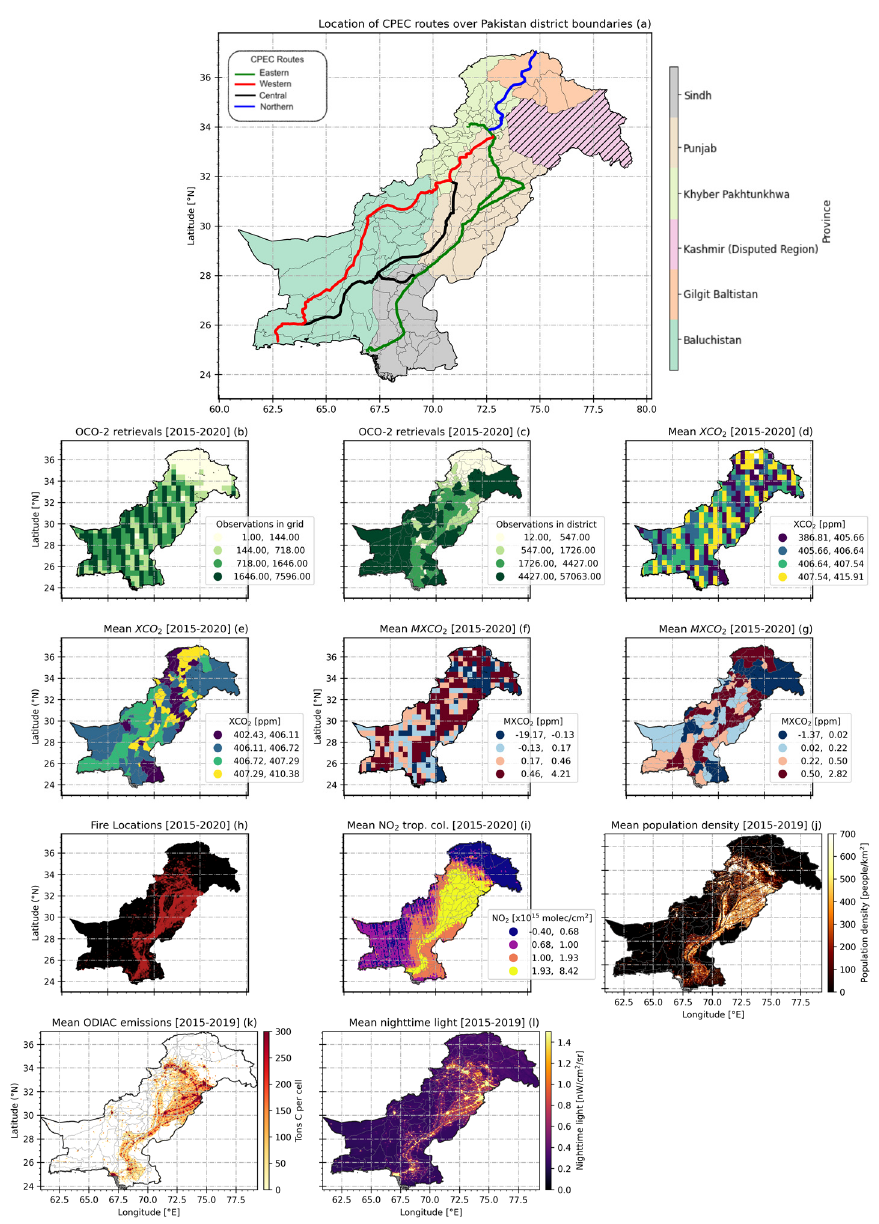
Figure 4. ( a ) District and administrative unit boundaries of Pakistan along with the CPEC routes and spatial distribution of ( b ) OCO-2 retrievals over a grid of 0.5 × 0.5 degrees, ( c ) OCO-2 retrievals observed by each district, ( d ) mean XCO 2 concentration over a grid of 0.5 × 0.5 degrees, ( e ) mean XCO 2 concentration in each district, ( f ) mean MXCO 2 concentration over a grid of 0.5 × 0.5 degrees, ( g ) mean MXCO 2 concentration in each district, ( h ) fire locations, ( i ) mean NO 2 tropospheric columns, ( j ) mean population density, ( k ) mean ODIAC emissions, and ( l ) mean nighttime lights over Pakistan. Figure 4d,e show the annually averaged XCO 2 concentration over a spatial grid of 0.5 MXCO 2 estimated using the OCO-2 retrievals is also displayed over a 0.5 × 0.5 degree anthropogenic CO 2 concentrations. Surprisingly, higher MXCO 2 concentrations were ob- served over the districts located along the China–Pakistan Economic Corridor (CPEC) routes shown in Figure 4a. Moreover, most of the districts in Punjab and Sindh are sur- rounded by cropland (Figure 1b). The spatial pattern of increased MXCO 2 over Punjab